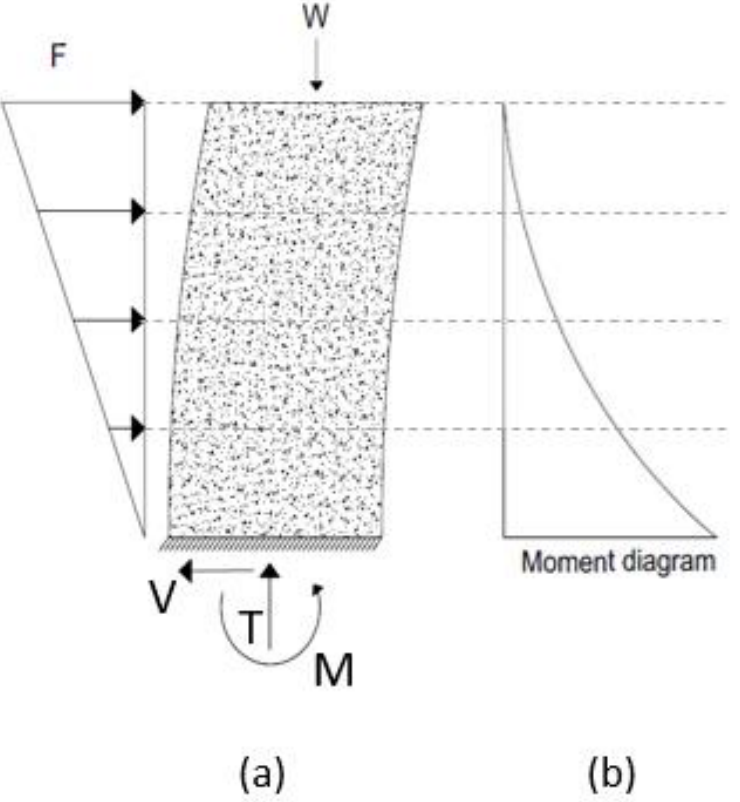
Figure 2. ( a ) Wall base reactions, ( b ) bending moment diagram of fixed-base SSWs exposed to lateral force.